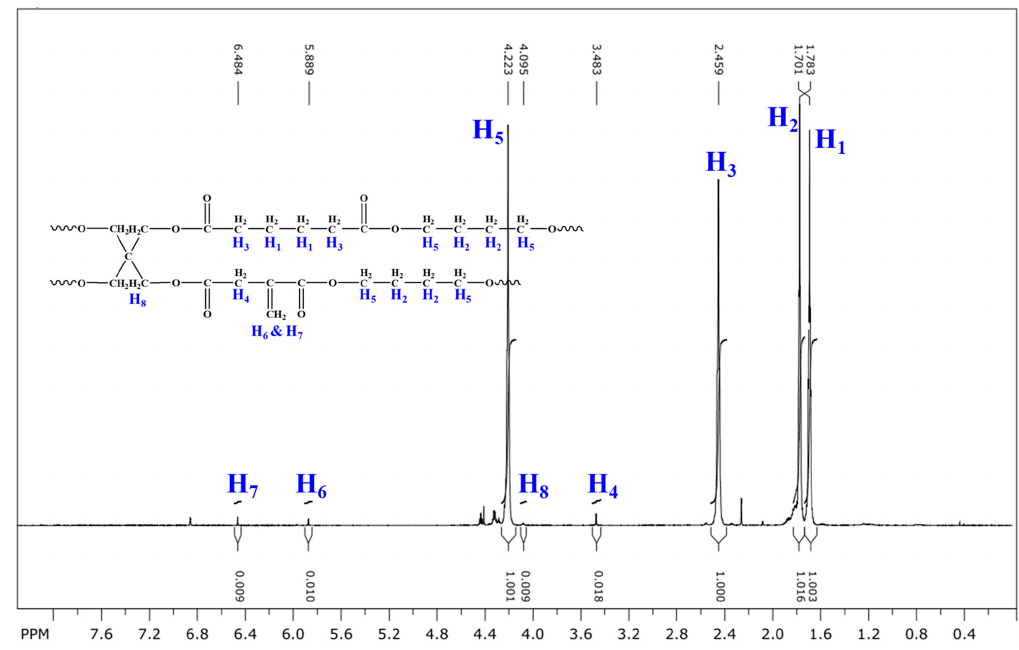
Figure 1. 1 H NMR spectra of PBABI copolyester with PE at a ratio of BA/BI = 9/1.